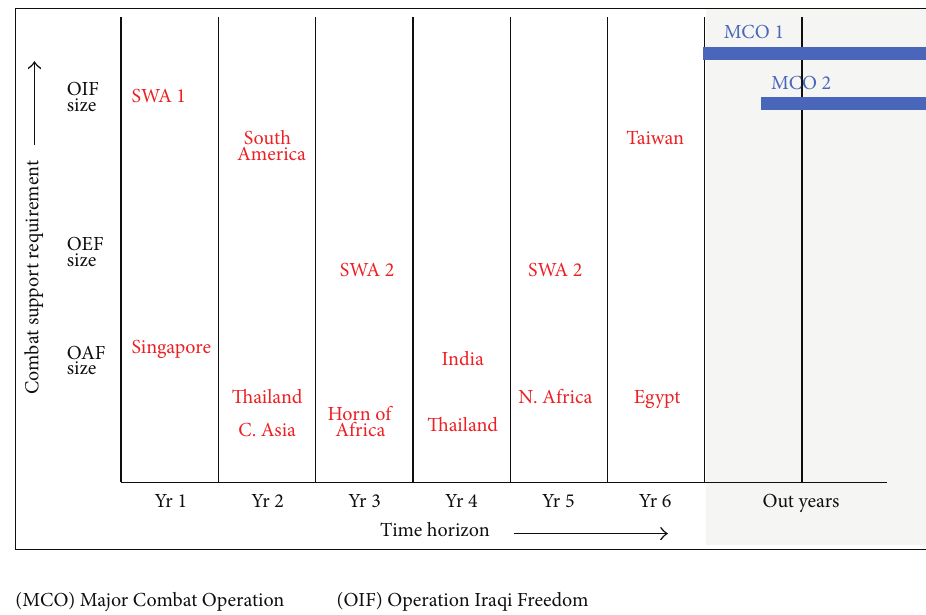
Figure 1: Evaluated scenario, with combat support requirements over